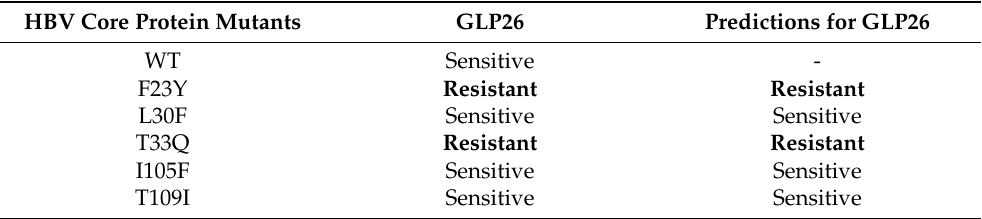
Figure 5. Inhibition of HBeAg secretion in HBV wild-type and core protein mutants at 10 µM GLP- 26. Table 3. Experimental results for the selected mutations in HBV core protein for GLP-26. HBV Core Protein Mutants